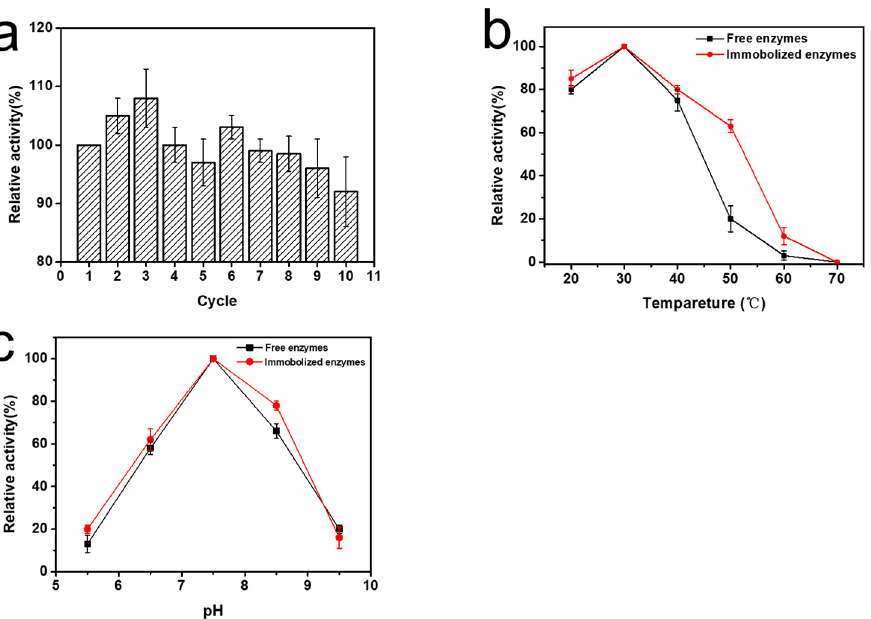
Figure 4. ( a ) Reusability of F6P reaction catalyzed by immobilized enzymes, ( b ) thermostability of immobilized enzymes and free enzymes incubated 2 h at different temperature, and ( c ) pH stability of immobilized enzymes and free enzymes incubated 2 h at different pH. 2.5. Purification of PMI from Crude Enzyme Solution by Ni-Chelated Ion Exchange Resin Column